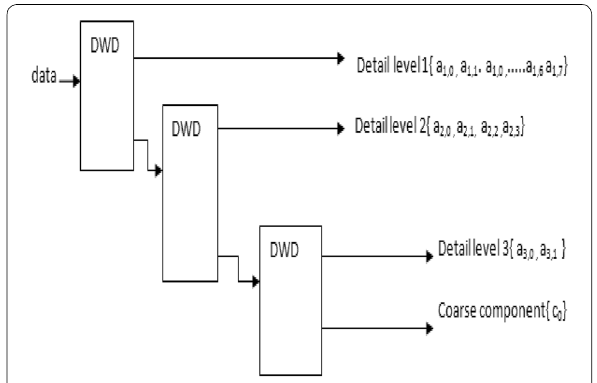
Fig. 2 Discrete wavelet decomposition (3